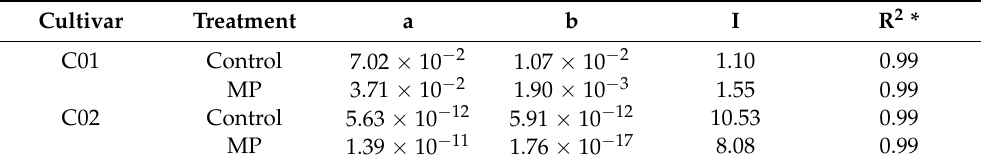
Table 2. Parameters of the Bleasdale YD model given by y = x (A + bx θ ) − 1/ θ and adjusted for the water absorption curve in soybean seeds before and after exposure to magneto-priming